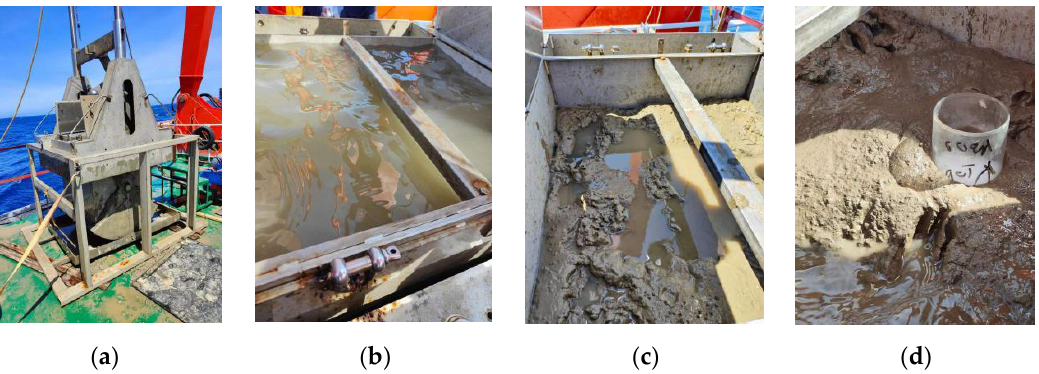
Figure 4. Box sampler and retrieved soil samples. ( a ) Box sampler, ( b ) In situ sample, ( c ) Seafloor soil, ( d ) Field sampling.